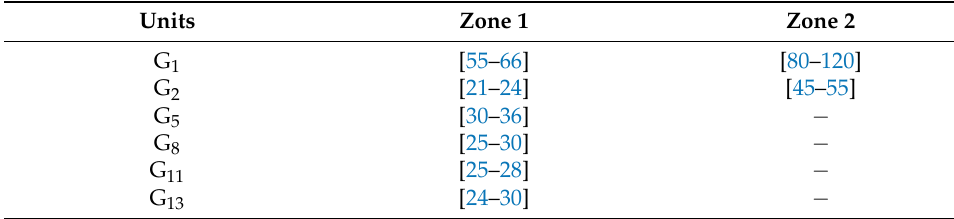
Table A3. Prohibited operating zones of units.